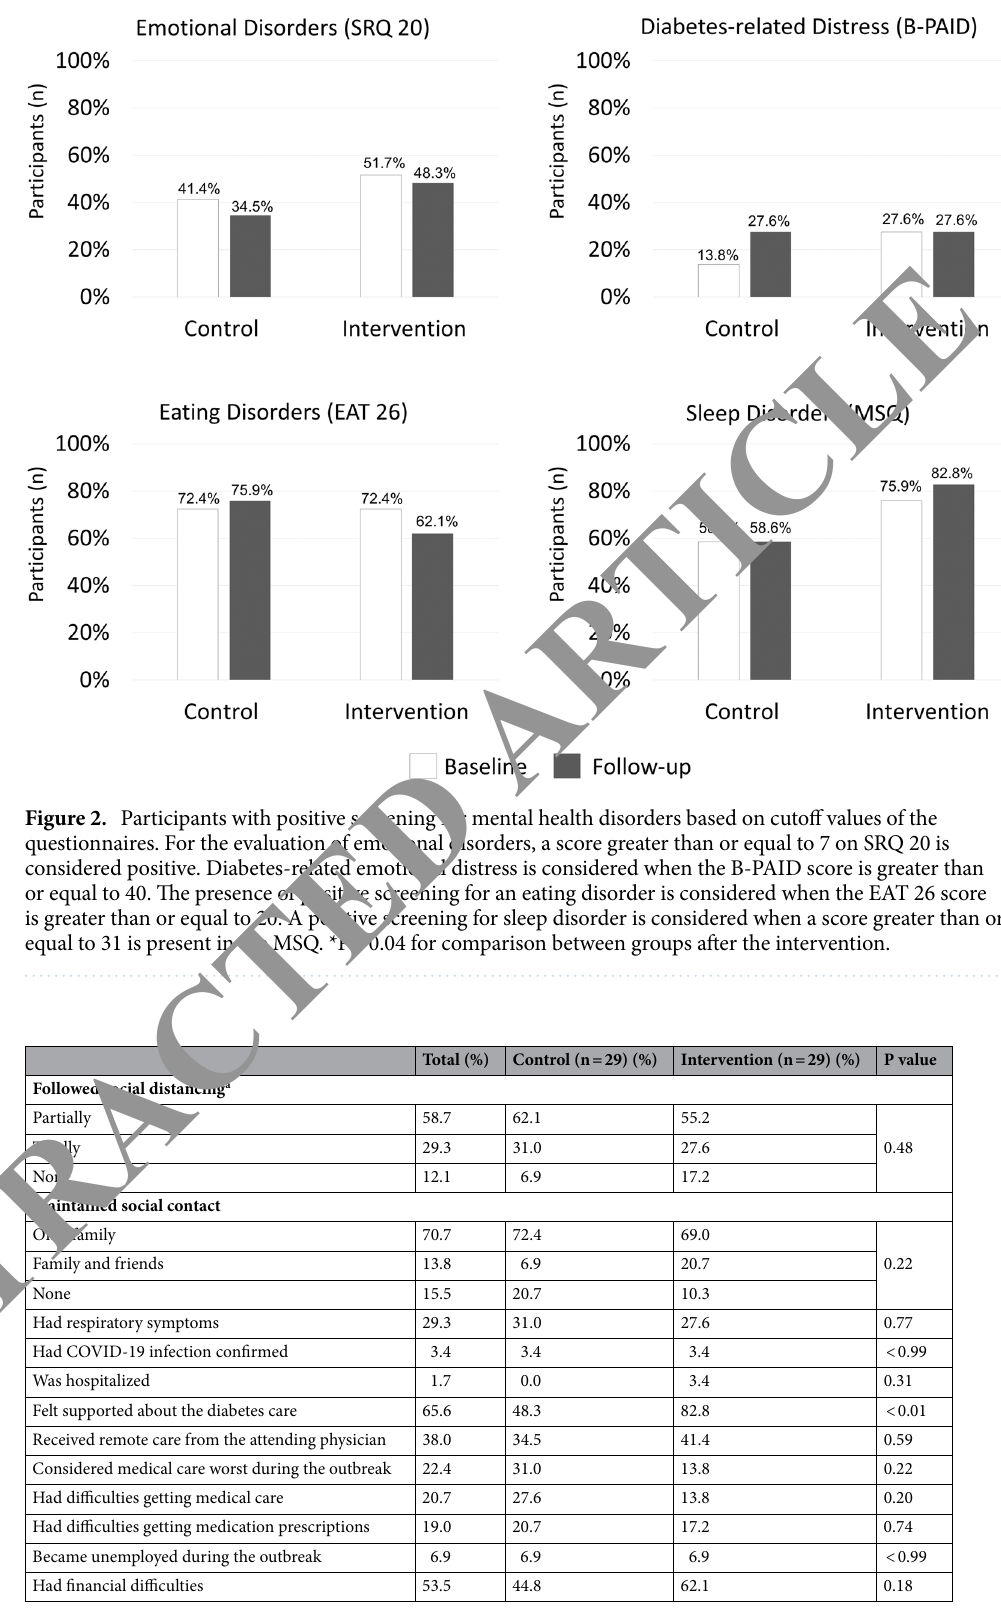
Table 2. Assessment of clinical, psychosocial aspects and perceptions about diabetes care after 16 weeks of follow-up during the COVID-19 outbreak. Data are %. α ≤ 0.05 indicates significant difference. a Partial social distancing includes patients who left home only for basic activities, such as market, pharmacy and health care. Total social distancing includes patients who followed the orientation of home-staying